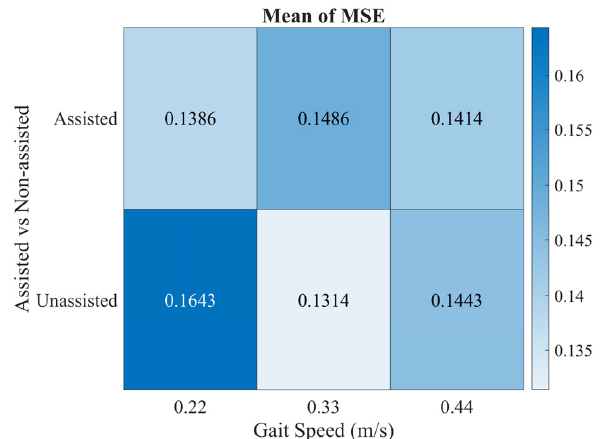
Figure 7. Variation of MSE regarding the gait speed (0.22, 0.33, and 0.44 m/s) and walking condition (assisted vs. non ‐ assisted gait).